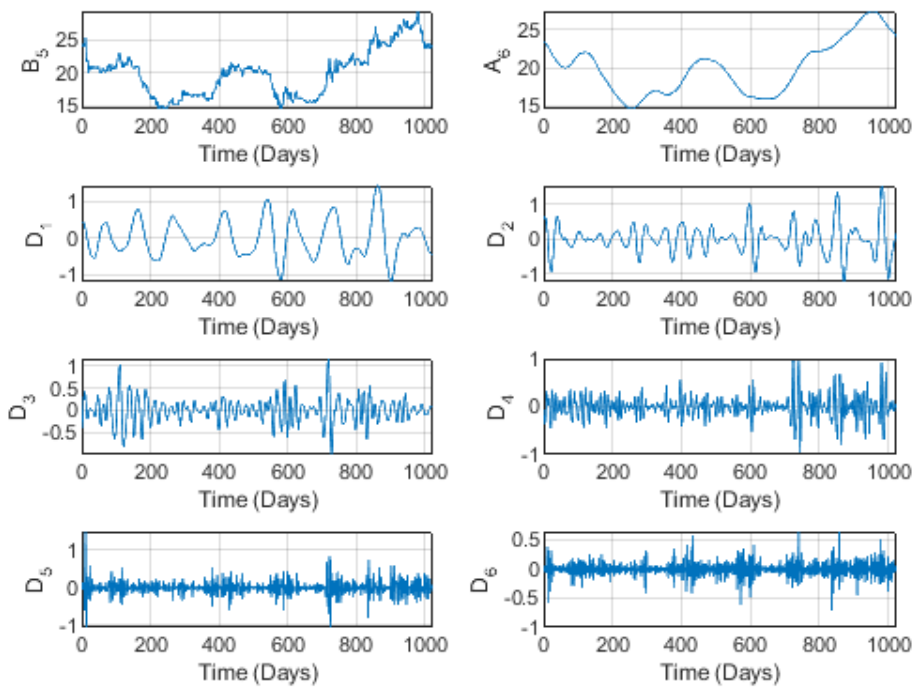
Figure 9. The wavelet decomposition of the EIC brand B 5 prices at level